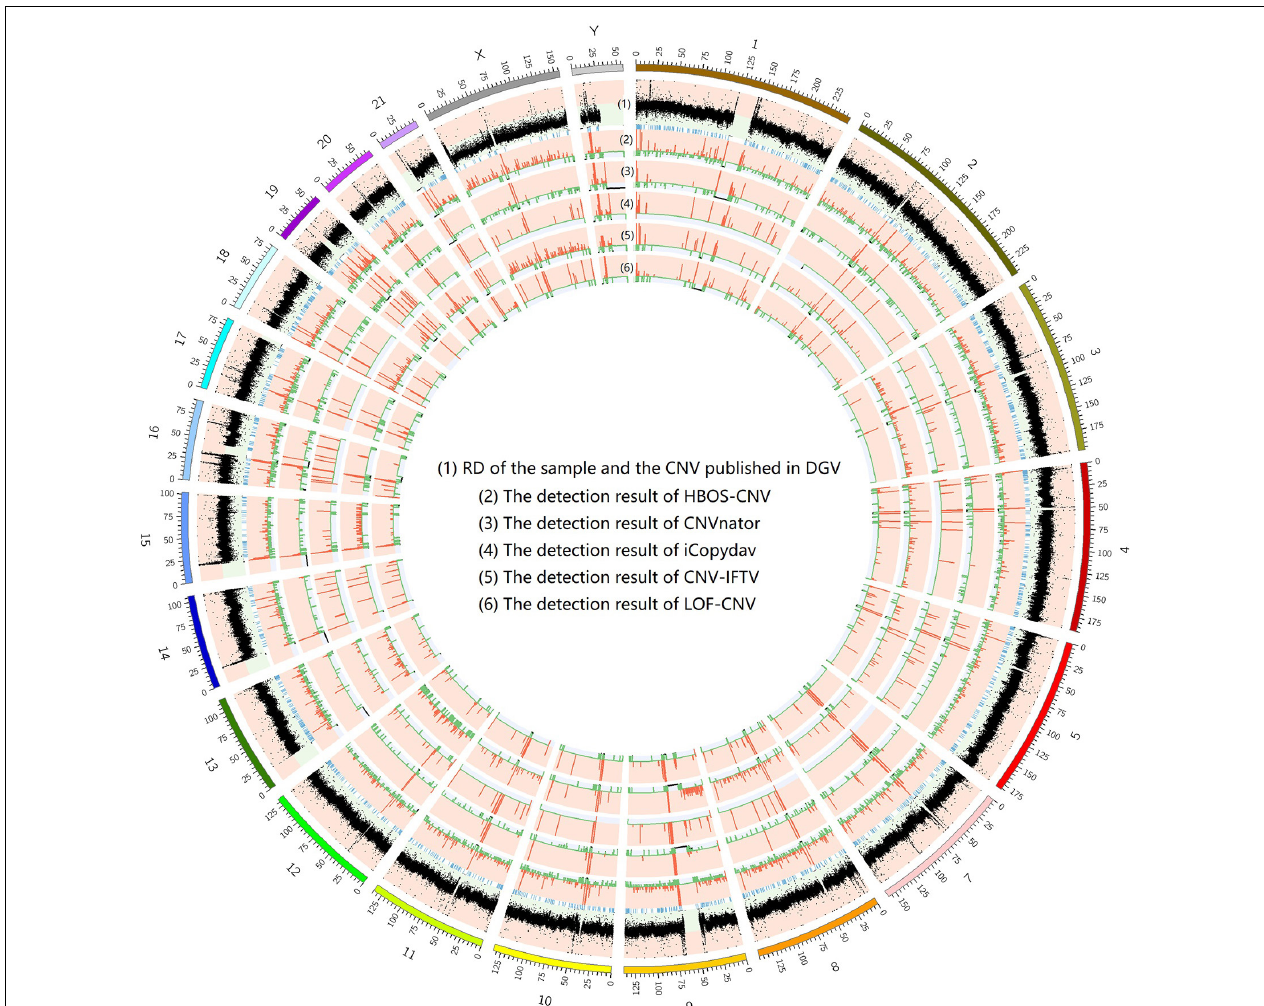
FIGURE 8 | The detection of all whole genomes of NA19239 is shown, with the circles representing (1) RD, and CNV published in DGV (2) the CNVs detected with HBOS-CNV, (3) the CNVs detected with CNVnator, (4) the CNVs detected with iCopyDav, and (5) the CNVs detected with CNV-IFTV, (6) the CNVs detected with LOF-CNV, from the outside to the